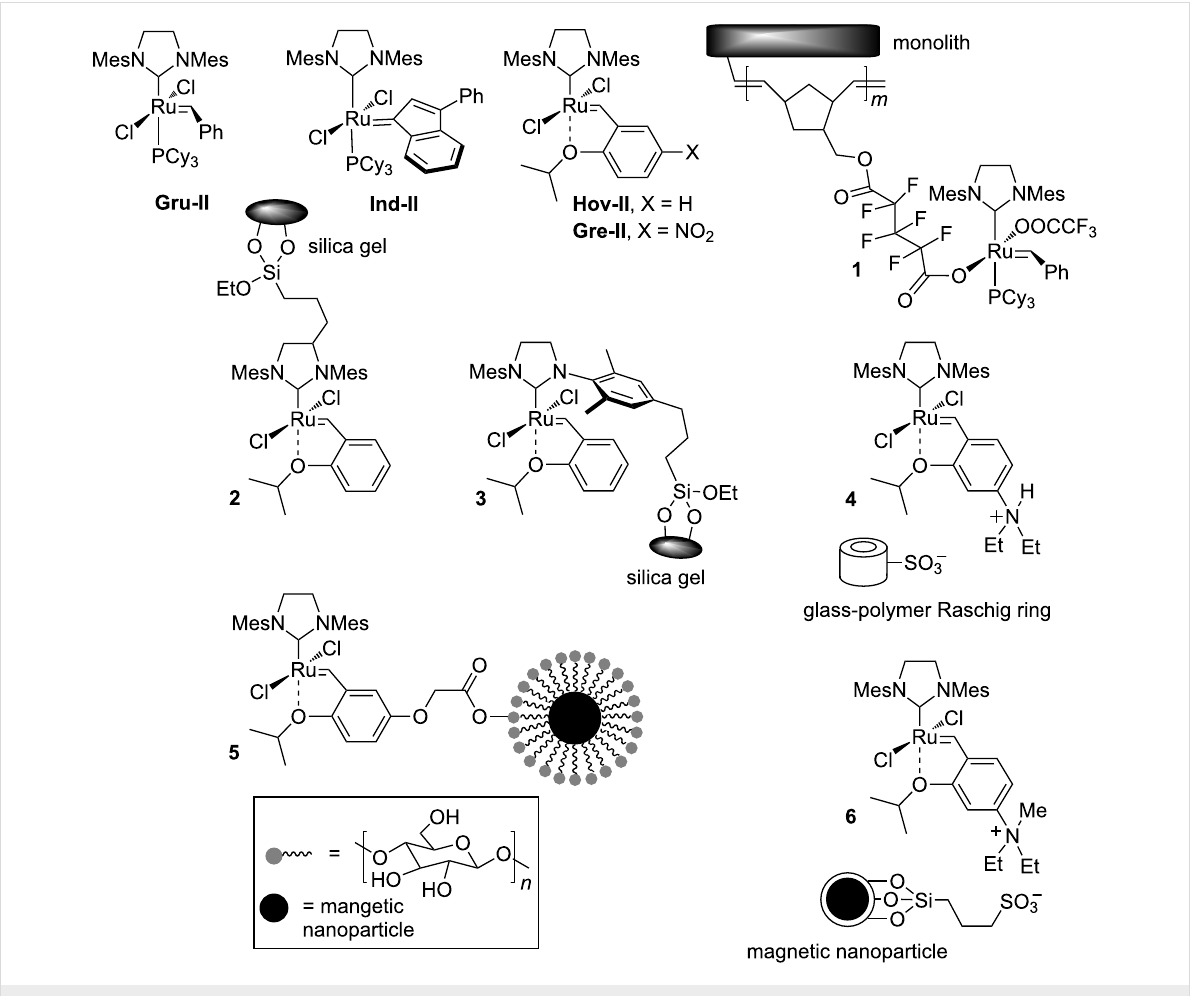
Figure 1: Selected classical and heterogeneous ruthenium